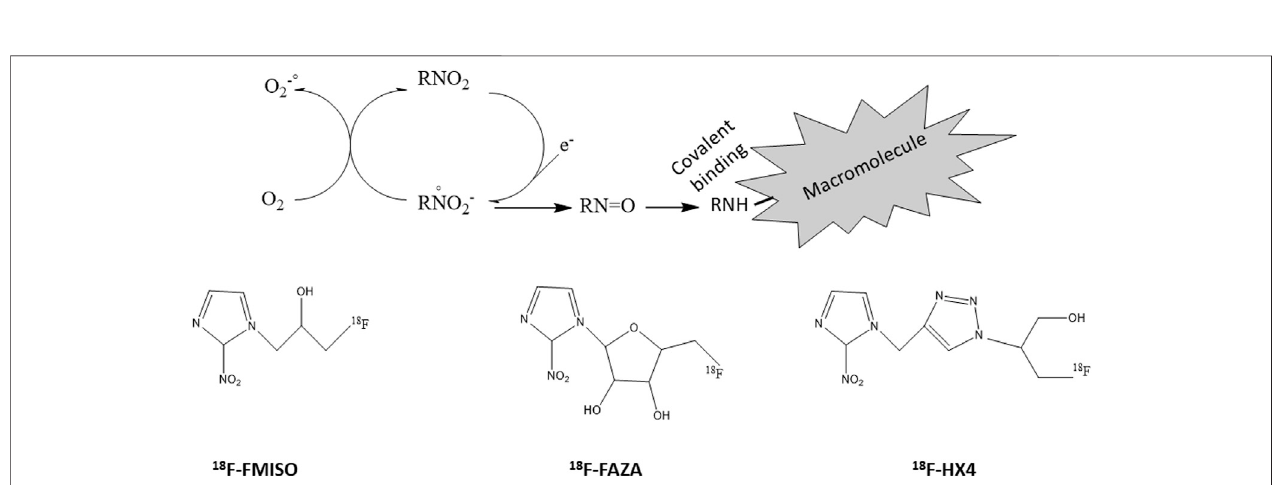
FIGURE 7 | Radiolabelled nitroimidazoles. Top: Inside cells, nitroimidazoles (RNO 2 ) are metabolized by reduction. This process is reversible under normoxic conditions leading to an equilibrium of the nitroimidazoles between the intra- and extracellular compartment. However, if cells are hypoxic, the radiotracer is further reduced and trapped by reacting with cellular macromolecules. Bottom: structures of commonly used radiolabeled nitroimidazoles ( 18 F-FMISO, 18 F-FAZA, 18 F-HX4).